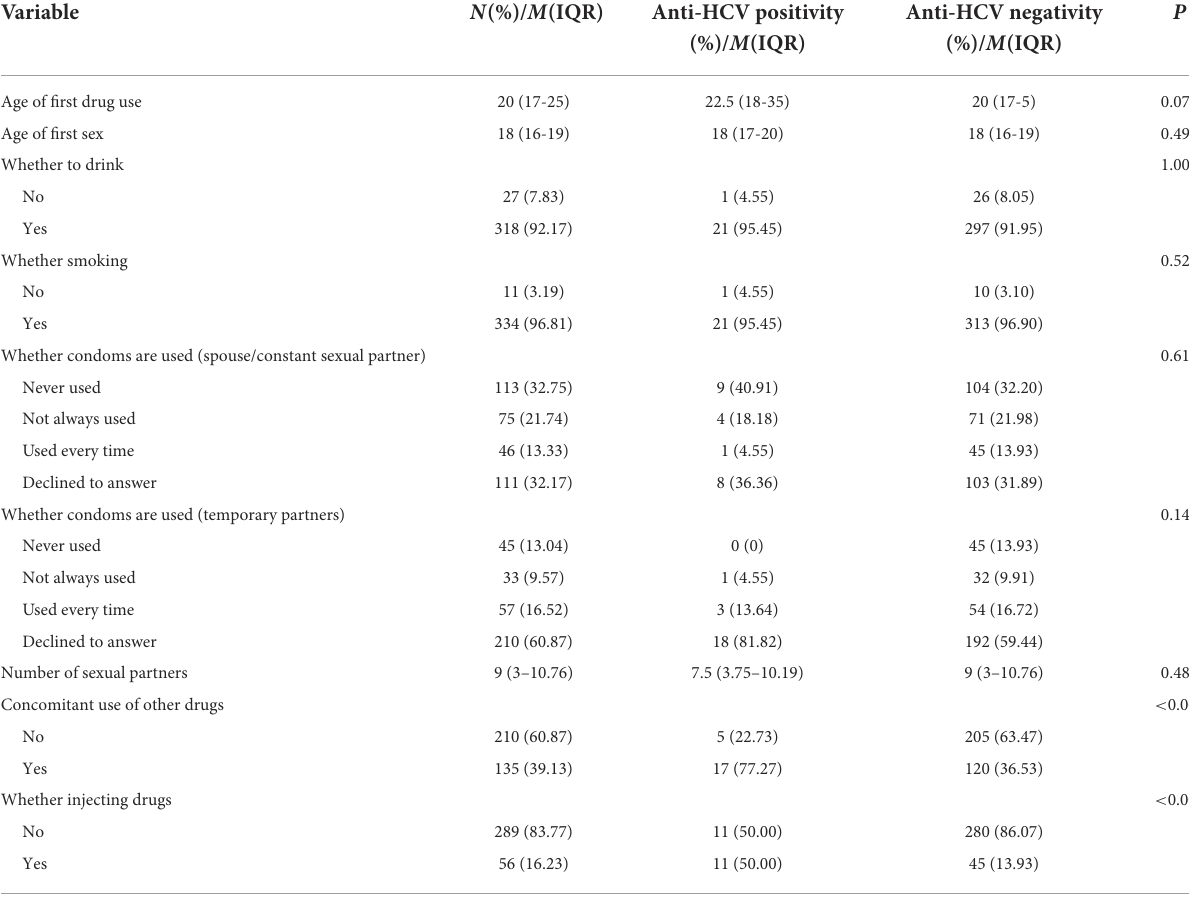
TABLE 3 The relationship between risk-related behavior and anti-HCV positivity among ATS users ( N = 345).